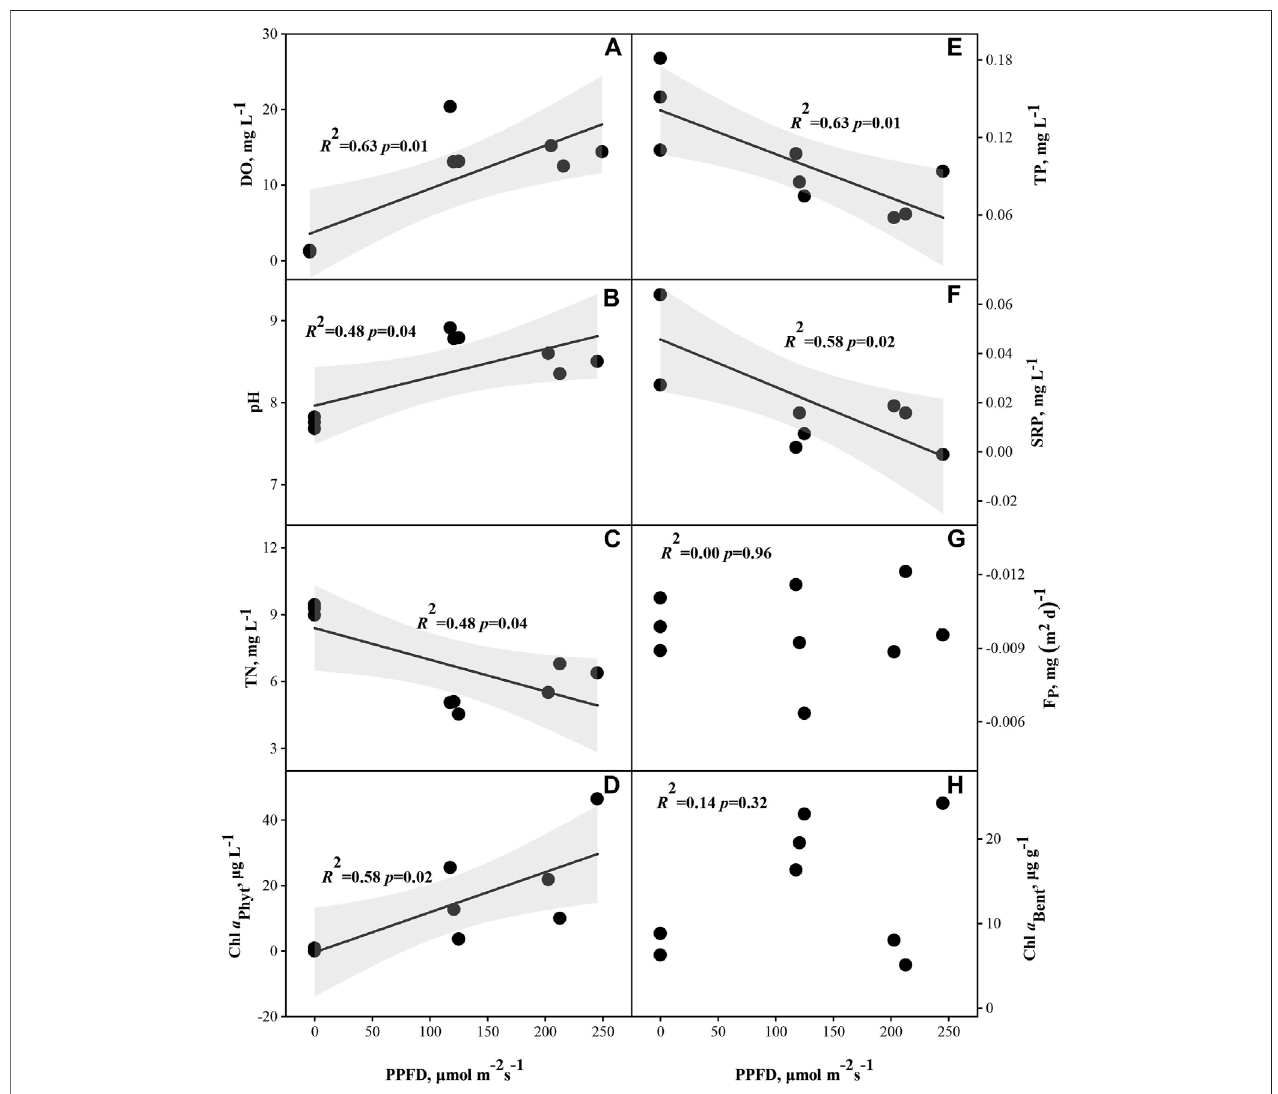
FIGURE 4 | Relationships between photosynthetic photon fl ux density (PPFD) and dissolved oxygen (DO) ( n = 9) (A) , pH (B) , total nitrogen (TN) (C) , total phosphorus (TP) (E) , soluble reactive phosphorus (SRP) (F) , P release fl ux (F P ) (G) , phytoplankton chlorophyll a (Chl a Phyt ) (D) and benthic algae chlorophyll a (Chl a Bent ) (H)